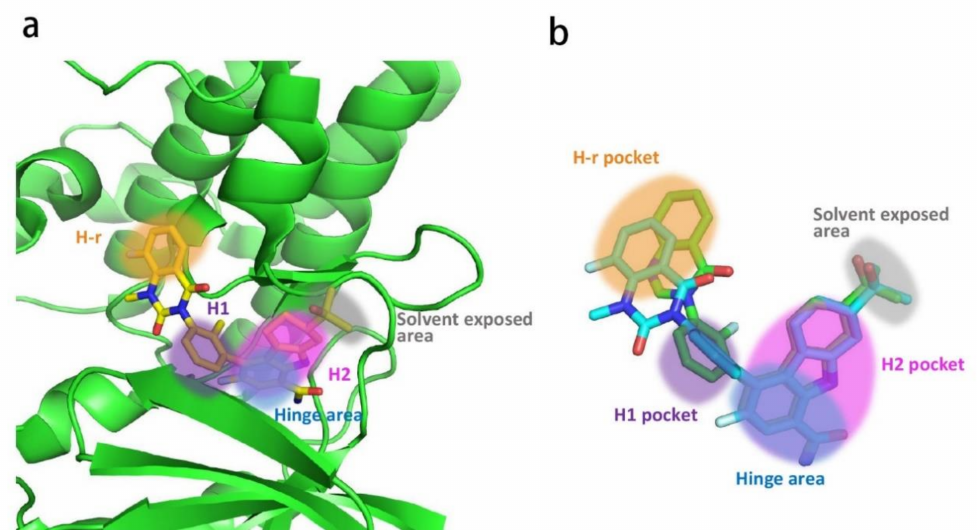
Figure 14. ( a ) The binding site of BTK complexed with BMS-986142 (41) (PDB code: 5T18) is depicted with key regions highlighted by different shaded colors. The binding site is indicated in the green cartoon representation. BMS-986142 is shown as sticks and the carbon atoms are depicted in yellow. Key areas for ligand binding, such as the H1 pocket (purple), H2 pocket (magenta), H-r pocket (orange), the solvent-exposed area (grey) and hinge area (light blue), are represented. ( b ) Superimposition of representative BTK inhibitors from crystallographic data within the binding site (Compound 39 and 41; PDB code: 5JRS and 5T18). Inhibitors are shown as sticks in different colors. Key areas for ligand binding are highlighted as in ( a ). All structural images were created using PyMoL [45].